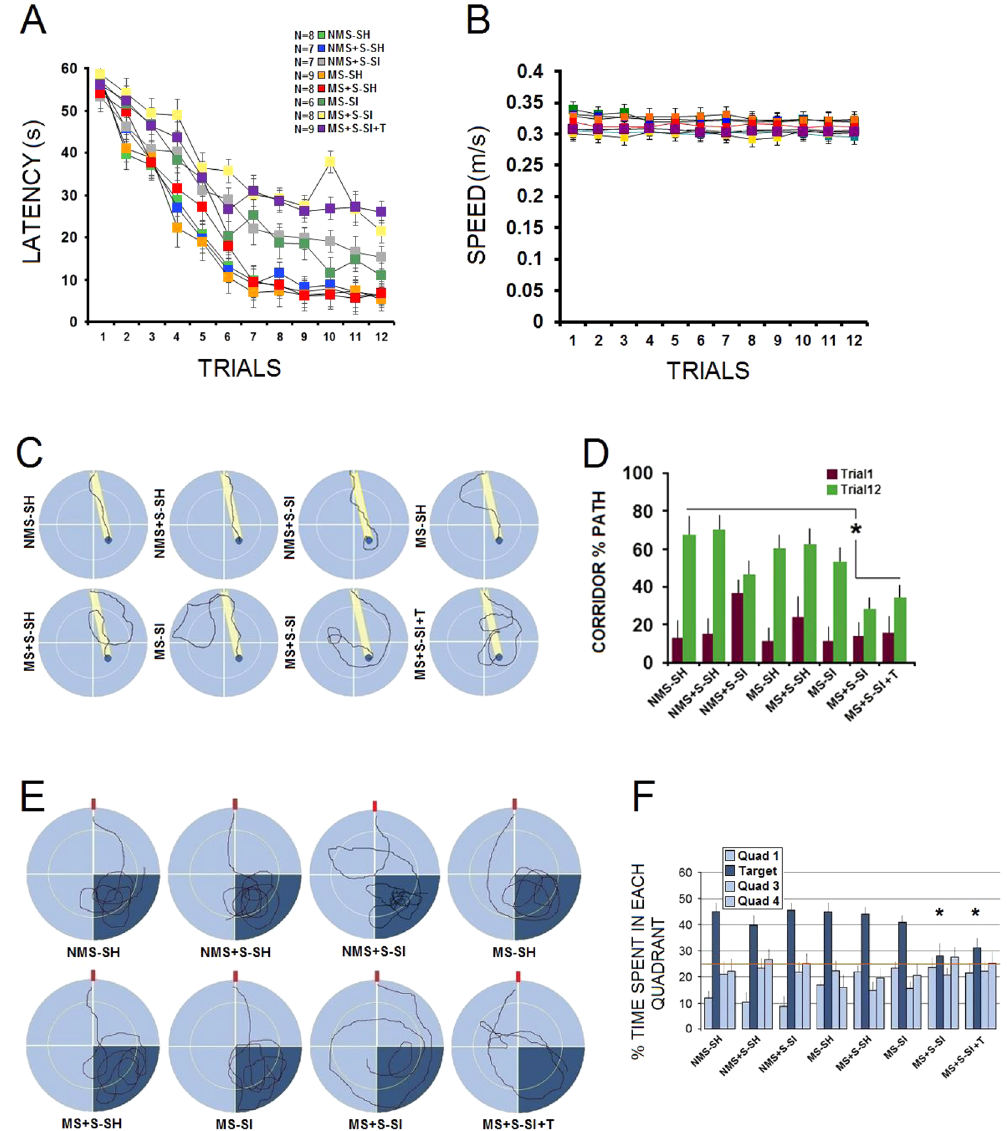
Figure 4. Combined ancestral and adulthood stress impair spatial working and reference memory . ( A ) Latency or time spent to find the hidden platform in the Morris water task using a one-day testing protocol and probe trial after stress. MS + S-SI and MS + S-SI + T rats displayed impaired spatial working memory when compared to controls. ( B ) Mean swim speed revealed no group differences. ( C ) Representative swim error in the last trial and ( D ) corridor percent time in the first and last trials indicating inaccurate swims relative to the platform location only in MS + S-SI and MS + S-SI + T rats. Yellow strips in plots indicate required swim corridors (Whishaw corridor) to the platform. ( E ) Representative probe trial trajectories illustrating focal search within the target quadrant in all groups except MS + S-SI and MS + S-SI + T rats. ( F ) The mean percentage of time spent in four quadrants of the task during the probe trial after completion of the single-session hidden platform paradigm. Rats in MS + S-SI and MS + S-SI + T groups showed no preference to spend time in the target quadrant (dark blue) indicating impaired reference memory. Asterisks indicate significant differences: * p ≤ 0.05; Repeated- Measure and One-Way ANOVA. Error bars show ±